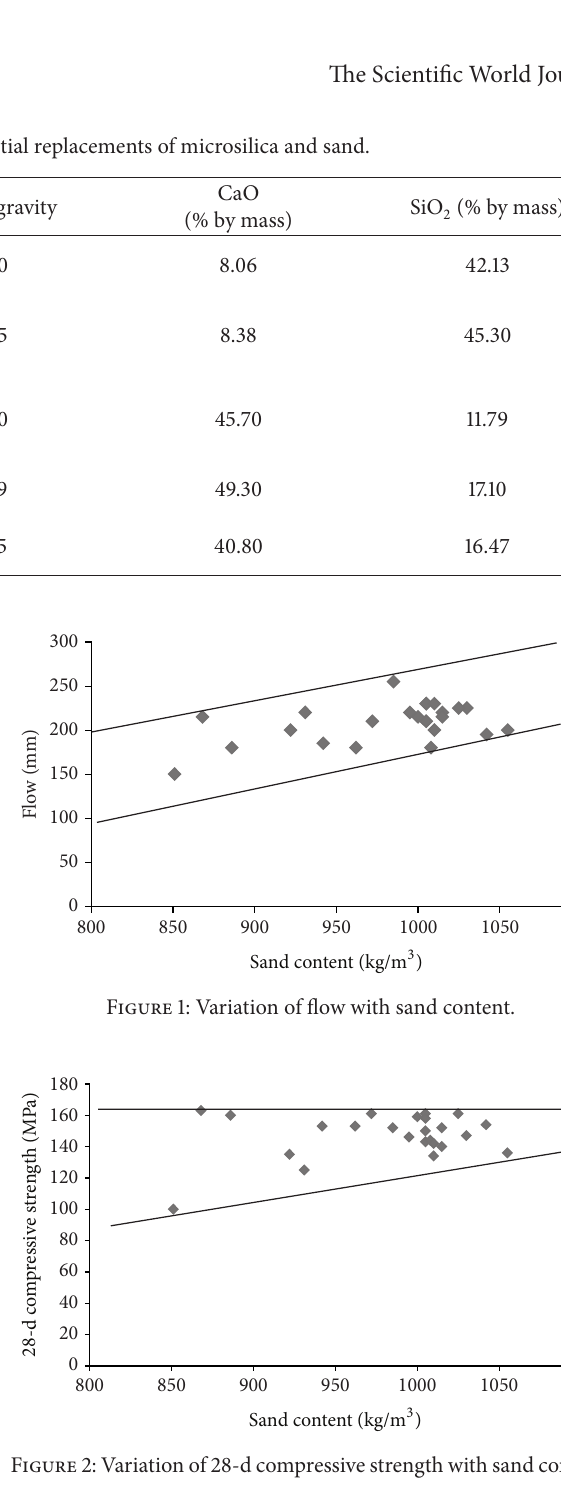
For examining the acceptable levels of partial replace- ments of microsilica and dune sand by the replacing mate- rials, the flow and 28-d compressive strength test results were plotted as shown in Figures 3, 4, 5, 6, 7, and 8. The minimum acceptable values of flow and 28-d compressive strength were considered as 180 mm and 150 MPa, respectively. The plots of flow values obtained for UHPC mixtures with NP and FA replacing microsilica, as shown in Figure 3, indicate that the flow is more than minimum limit at all